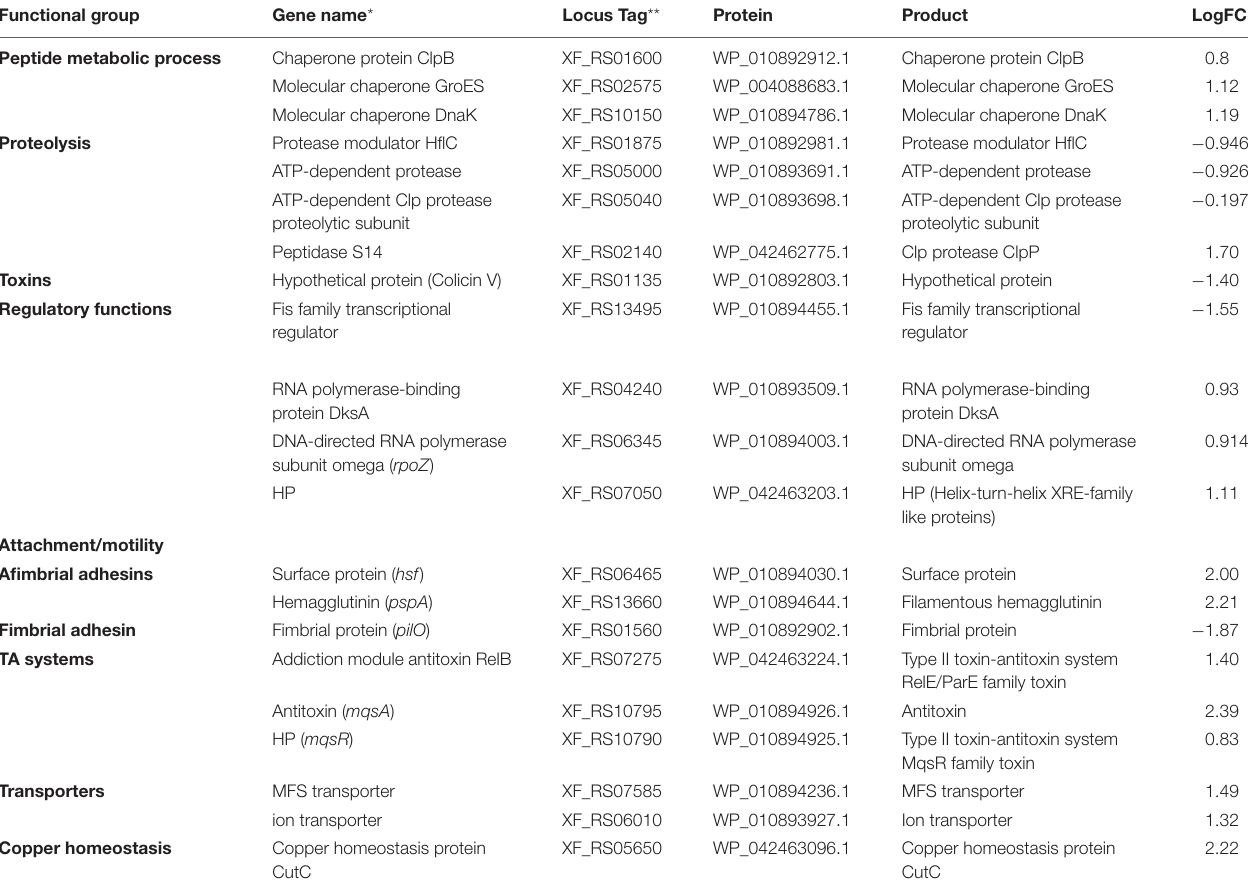
TABLE 2 | Genes modulated by MqsR in X. fastidiosa under copper